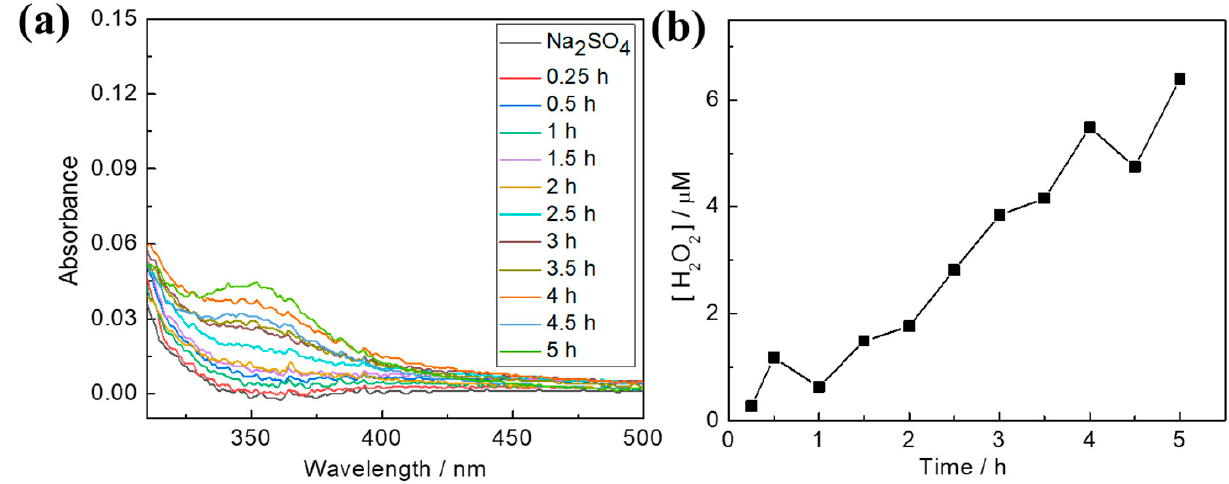
Figure 8. ( a ) UV–vis absorption spectra of molybdenum-triiodide indicator solution containing PEC cell solutions vs. PEC duration. ( b ) Production of H 2 O 2 over time during photoelectrocatalysis in O 2 -equilibrated electrolytes at a bias potential of − 0.4 V vs. SCE.